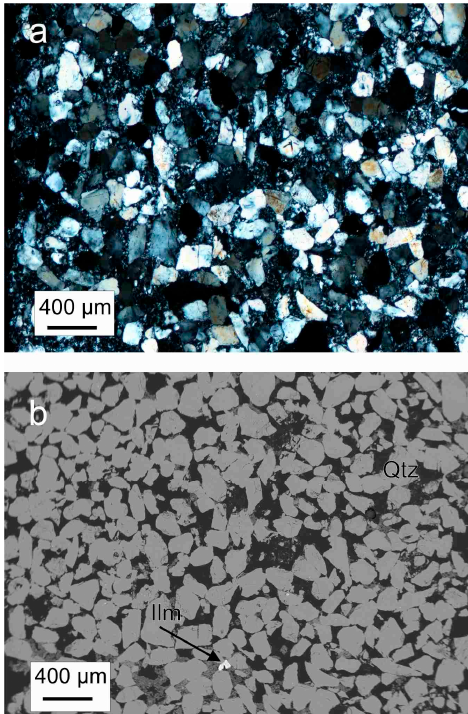
Figure 4. Petrography of the quartz sandstone from the Chełmo Mount. ( a ) Fine- to medium-grained, well sorted quartz sandstone, cemented by siliceous cement, polarized light microscopy image, crossed nicols; ( b ) SEM-BSE (Scanning Electron Microscope-BackScattered Electron) image of the same sample area; Ilm—ilmenite; Qtz—quartz.